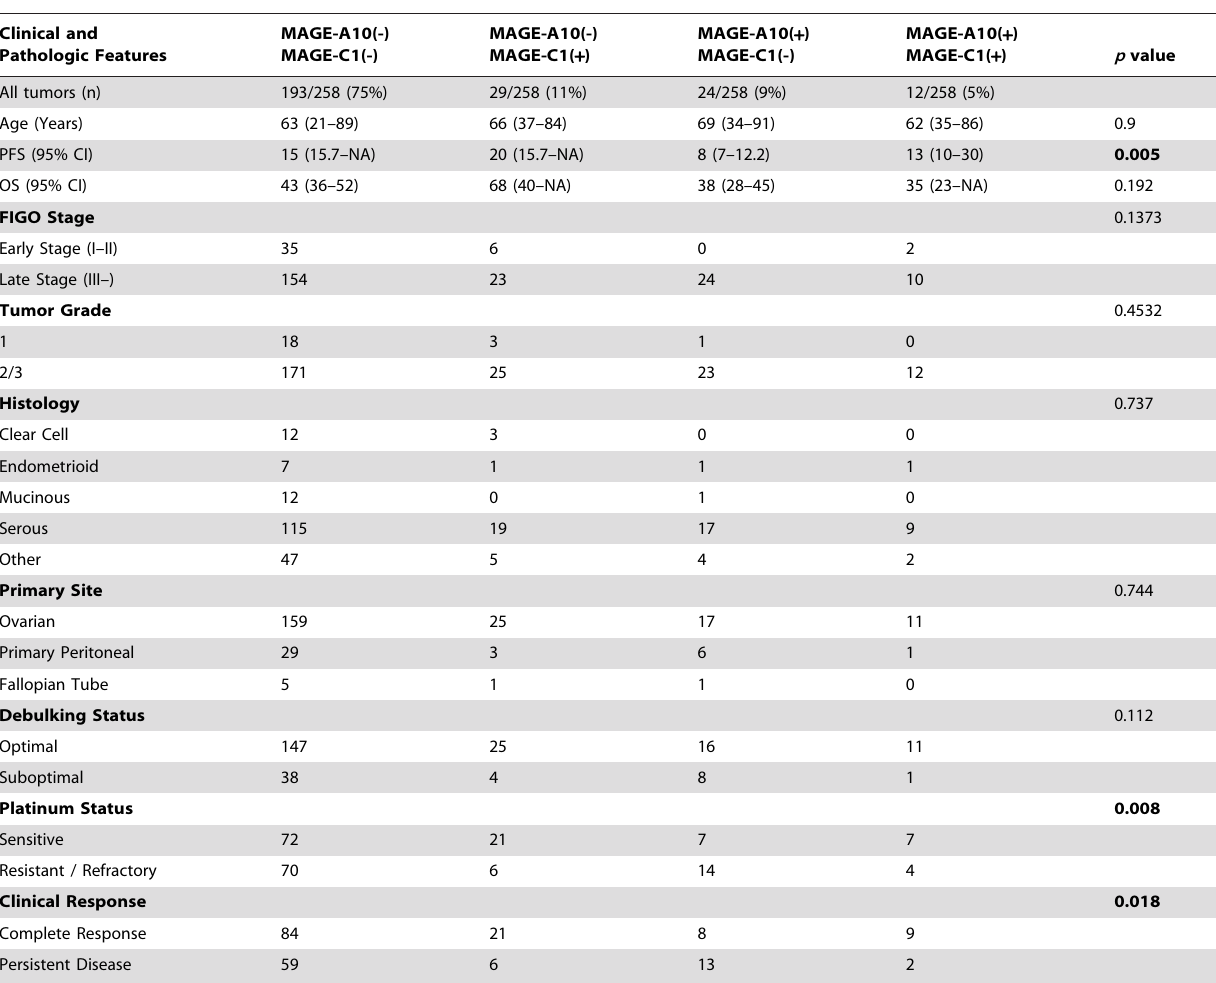
Table 3. Patient Characteristics by MAGE Expression.